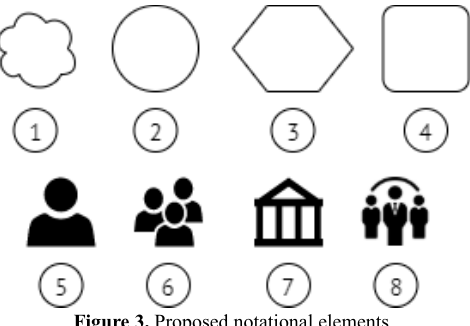
Figure 3. Proposed notational